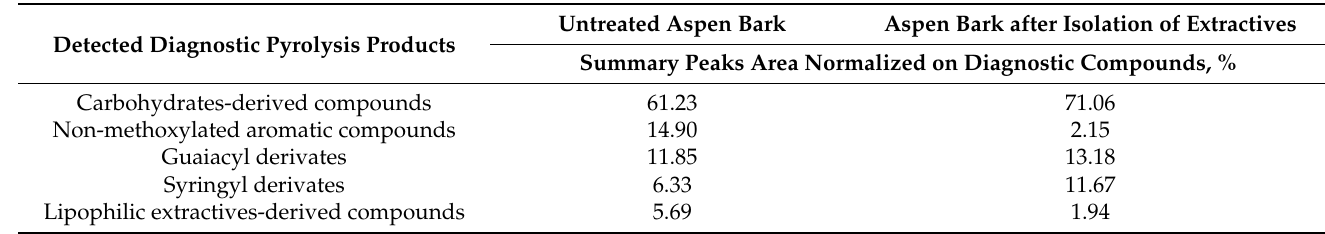
Table 1. Composition of diagnostic volatile pyrolysis products of untreated and extracted aspen bark. Untreated Aspen Bark Aspen Bark after Isolation of Extractives Detected Diagnostic Pyrolysis Products Summary Peaks Area Normalized on Diagnostic Compounds,